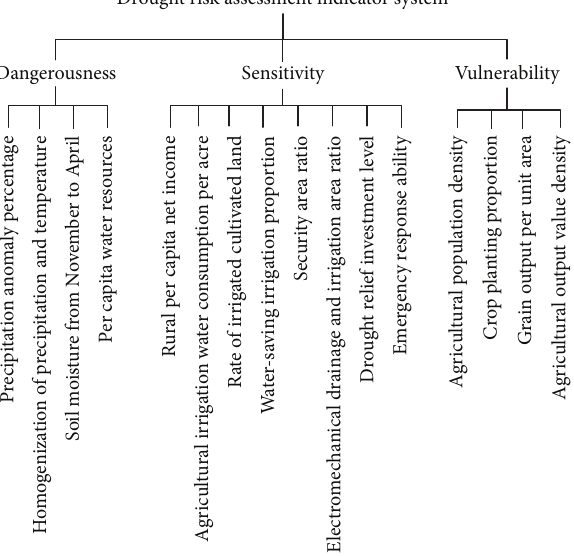
Figure 3: Indicator system of drought risk